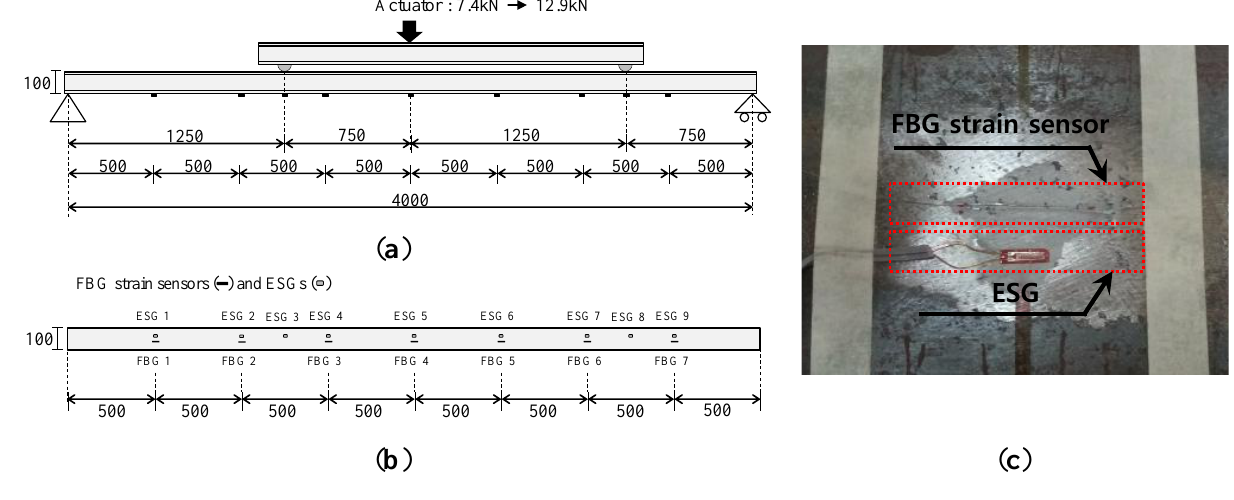
Figure 5. Loading by hydraulic jack and loading